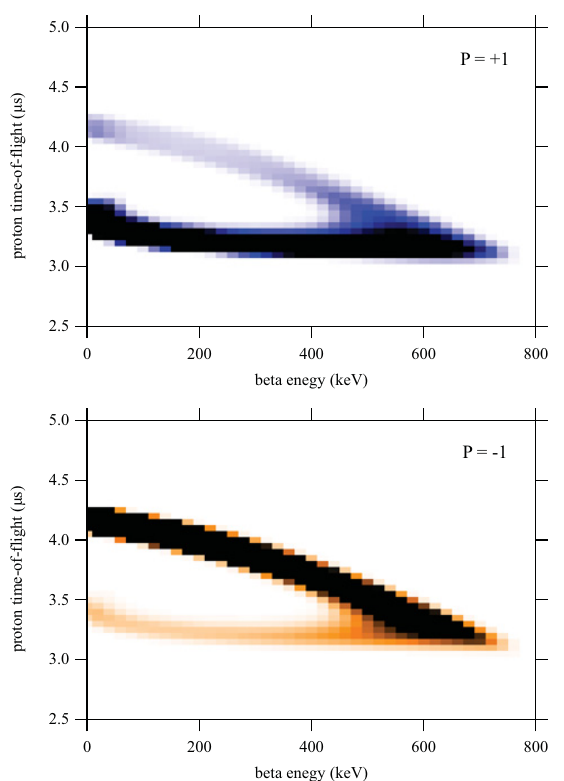
Figure 7. Monte Carlo simulation of the aCORN wishbone on a highly polarized neutron beam for two spin flip states P up (Top) and P down